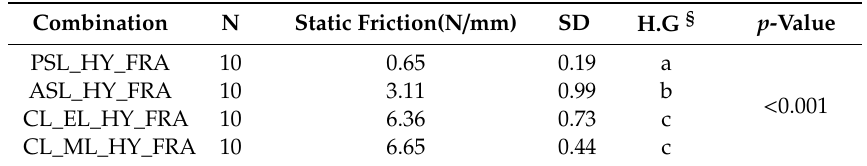
Table 8. Static friction values using hybrid section stainless steel wire and a friction reducer agent (HY_FRA). The letters show significance statistical di ff